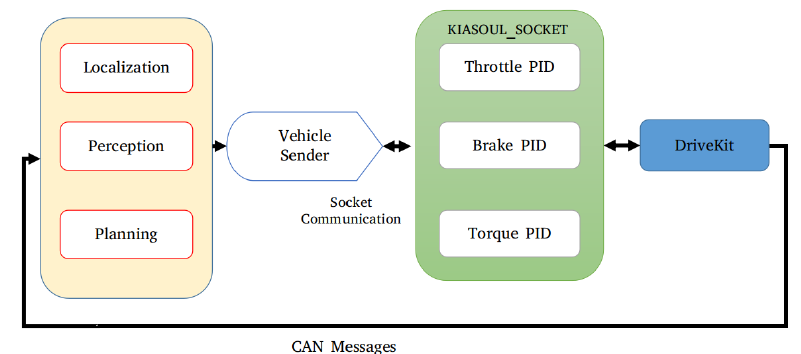
Figure 16. Vehicle sender receives the information from Planning and send the command to PID controller. Kiasoul-socket is composed of Throttle/Brake and Torque PIDs that sends the command to